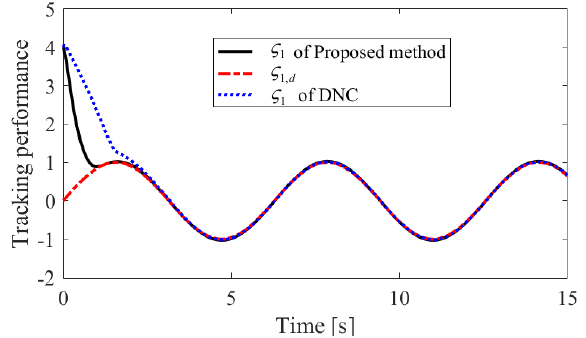
Figure 2. Tracking performance of ς 1, d in Case 1.